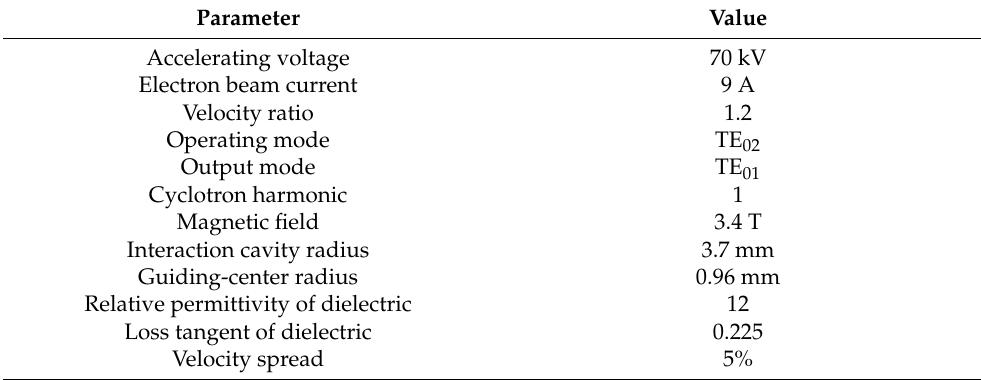
Table 1. Operating parameters of the W-band TE 02 mode gyro-TWT.